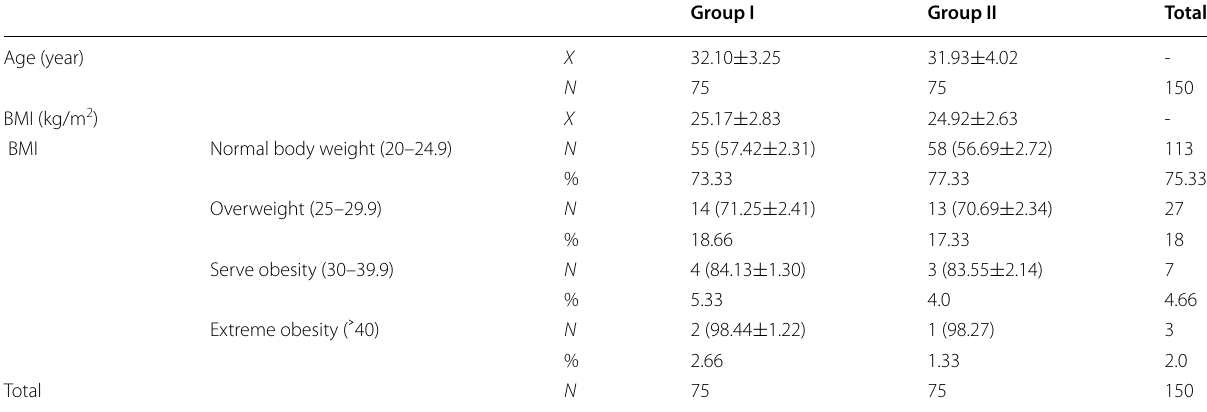
Data are expressed as number ( N ) and percentage (%)